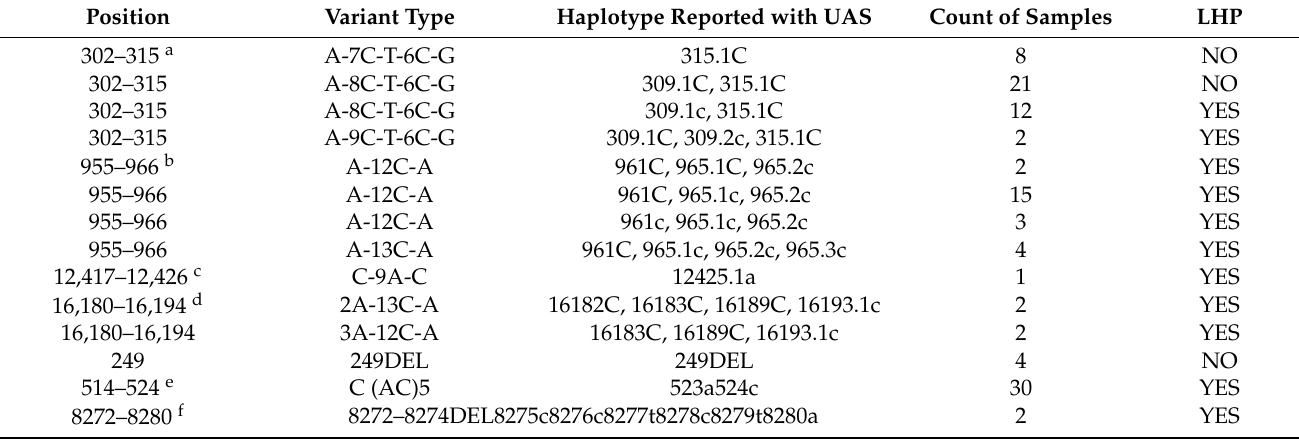
Table 4. Variants that caused the length variations in the mtDNA